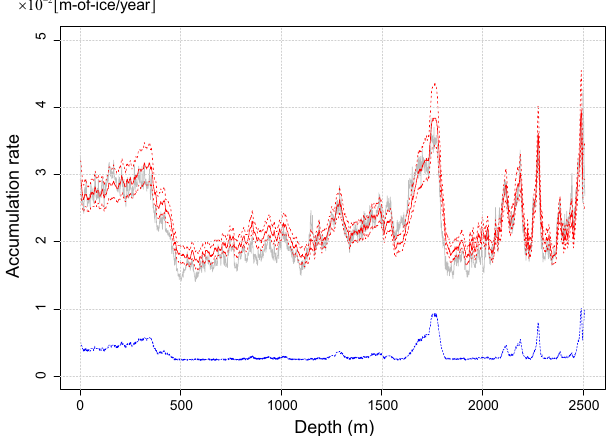
Figure 7. Estimated accumulation rate as a function of depth. The median of the posterior is indicated by a red solid line, the 10th and 90th percentiles are indicated by red dotted lines, the difference between the 10th and 90th percentiles is indicated by a blue dotted line, and the estimate by Parrenin et al. (2007) is indicated by a grey line.